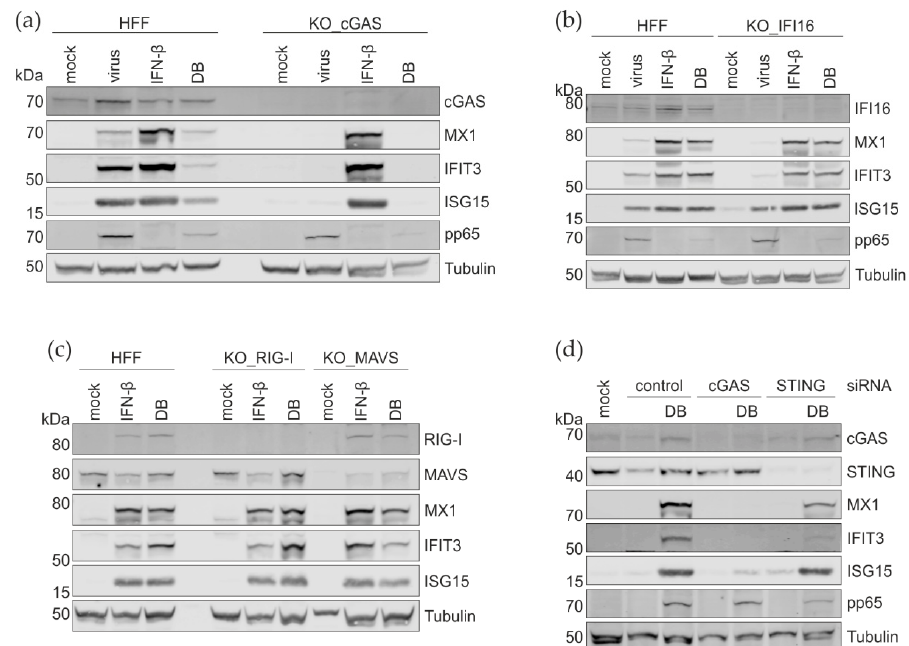
Figure 8. Western blot analysis of the impact of the depletion of the cytosolic sensors on the IRG- induction by DBs. ( a – c ) IRG protein levels in cGAS, IFI16, RIG-I, and MAVS CRISPR/Cas9